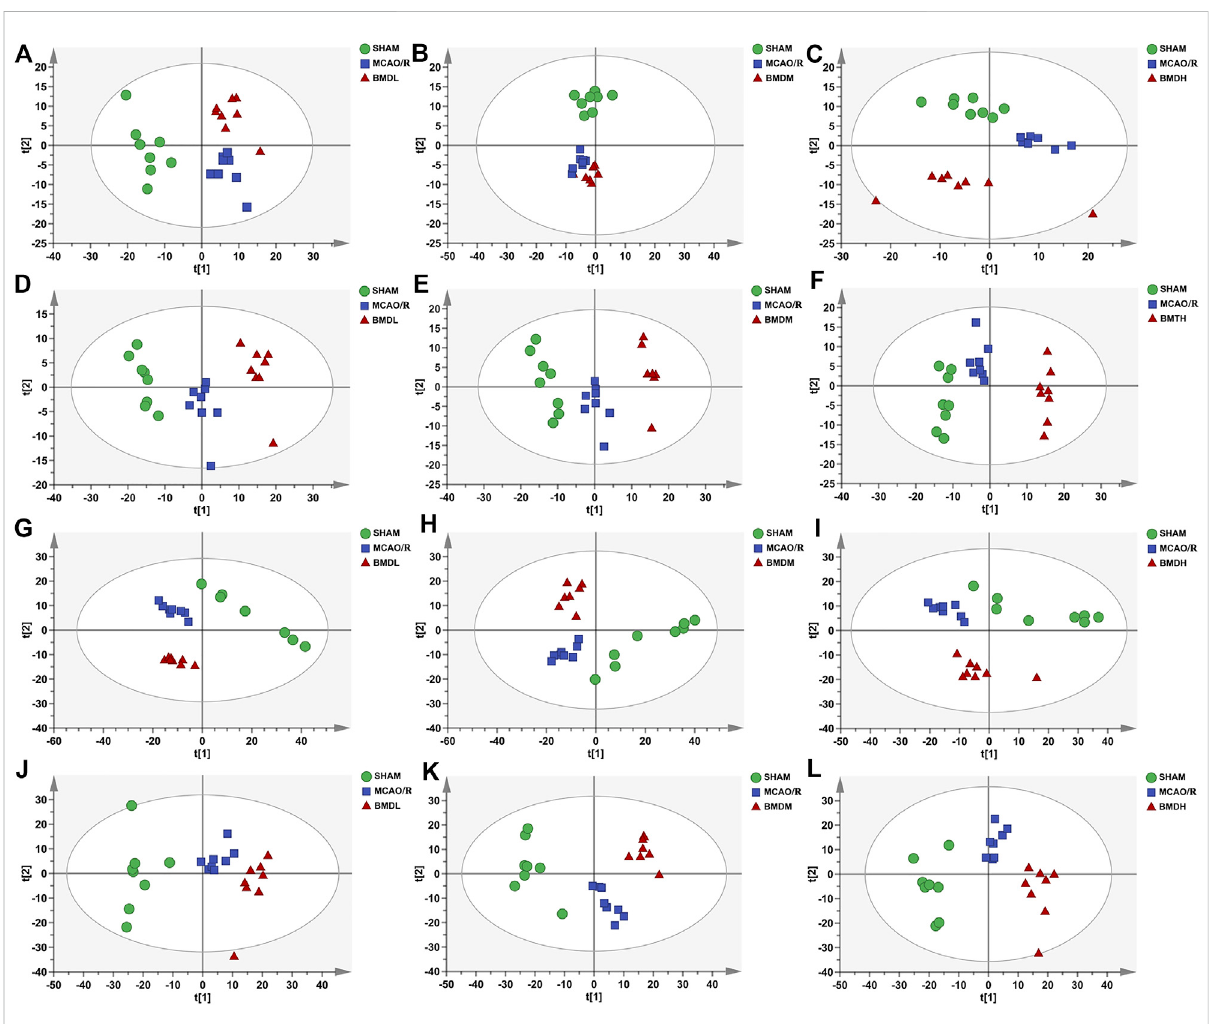
FIGURE 5 PCAscoreplotsofserumsamplesfromSHAM,MCAO/R,BMDL,BMDM,andBMDHinpositive (A – C) andnegative (D – F) ESImodes( n =8);PCA score plots of brain samples from SHAM, MCAO/R, BMDL, BMDM, and BMDH in positive (G – I) and negative (J – L) ESI modes ( n =